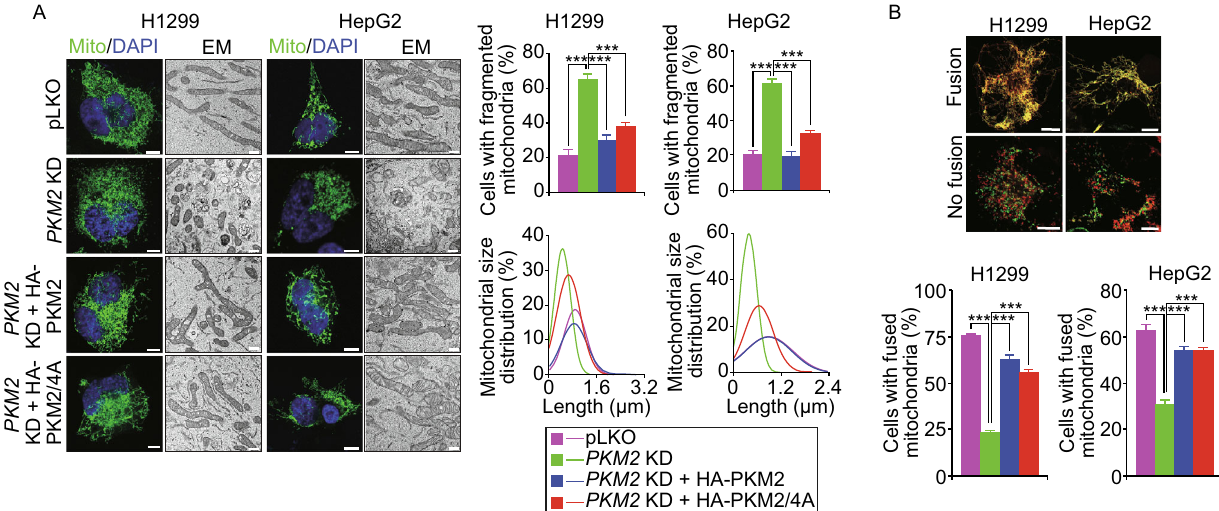
Figure 2. PKM2 promotes mitochondrial fusion. (A) Effect of PKM2 on mitochondrial morphology. Left panel: Representative confocal and electron microscopy (EM) images showing the effect of different PKM2 treatments on mitochondrial phenotypes in H1299 and HepG2 cells. In the confocal images, cells are labeled with Green FP-Mitochondrion (Mito). Right panel: Statistical analyses showing the proportion of cells with fragmented mitochondria and the distribution of mitochondrial size. DAPI, 4,6-diamidino- 2-phenylindole. n = 95 – 173 cells. (B) Representative images and statistical analyses showing the effect of PKM2 on mitochondrial fusion in H1299 and HepG2 cells. n = 150 cells. Scale bars for confocal imaging, 10 μ m. Scale bars for EM, 500 nm. PKM2/4A is the R73A/K270A/D296A/T328A mutant of PKM2. Data are shown as mean ± s.e.m. *** P <